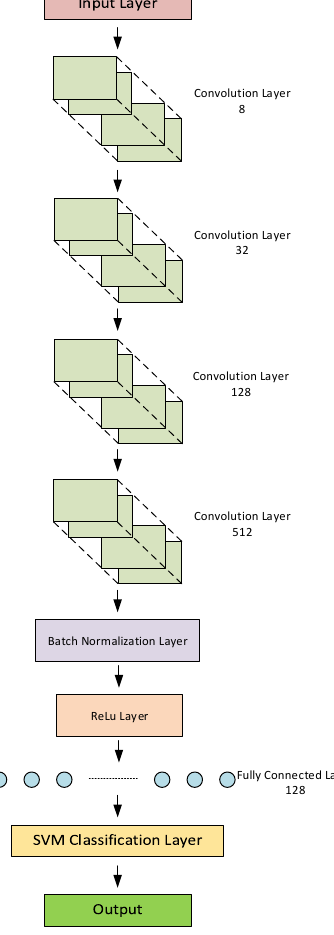
Figure 6. The hybrid deep learning architecture of the proposed method.